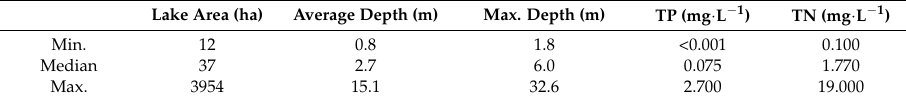
Table 1. Summary of lake morphology and nutrient concentrations in the study